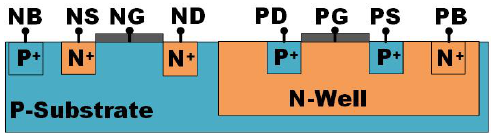
Figure 3: Cross section of standard CMOS transis-